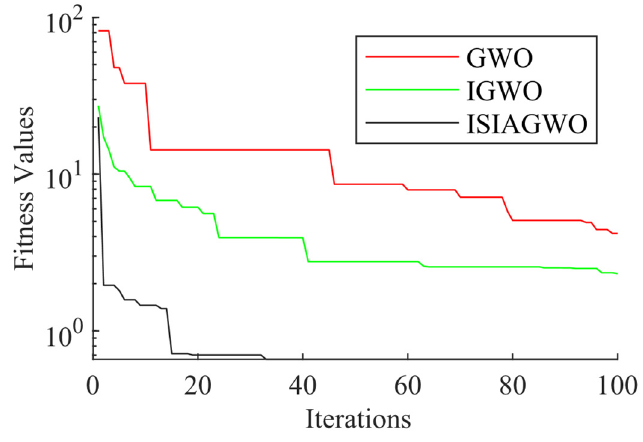
Figure 12. Convergence curves for DFIG’s parameter identification algorithm adaptation. The stator resistance of DFIG identification convergence curve, shown in Figure 13.